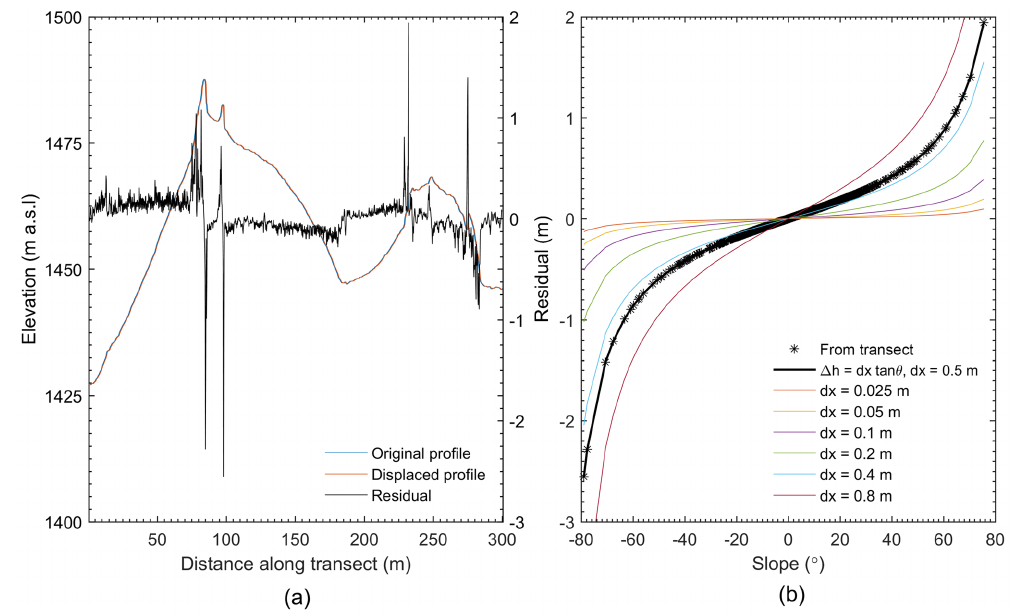
Figure 9. The vertical residual between two elevation profiles, extracted from the same DSM, along a common transect and offset horizontally by 0.5m (a) , and the resulting residuals plotted as a function of terrain surface slope, for the applied offset of 0.5m, and a range of other offsets (d x ) (b)